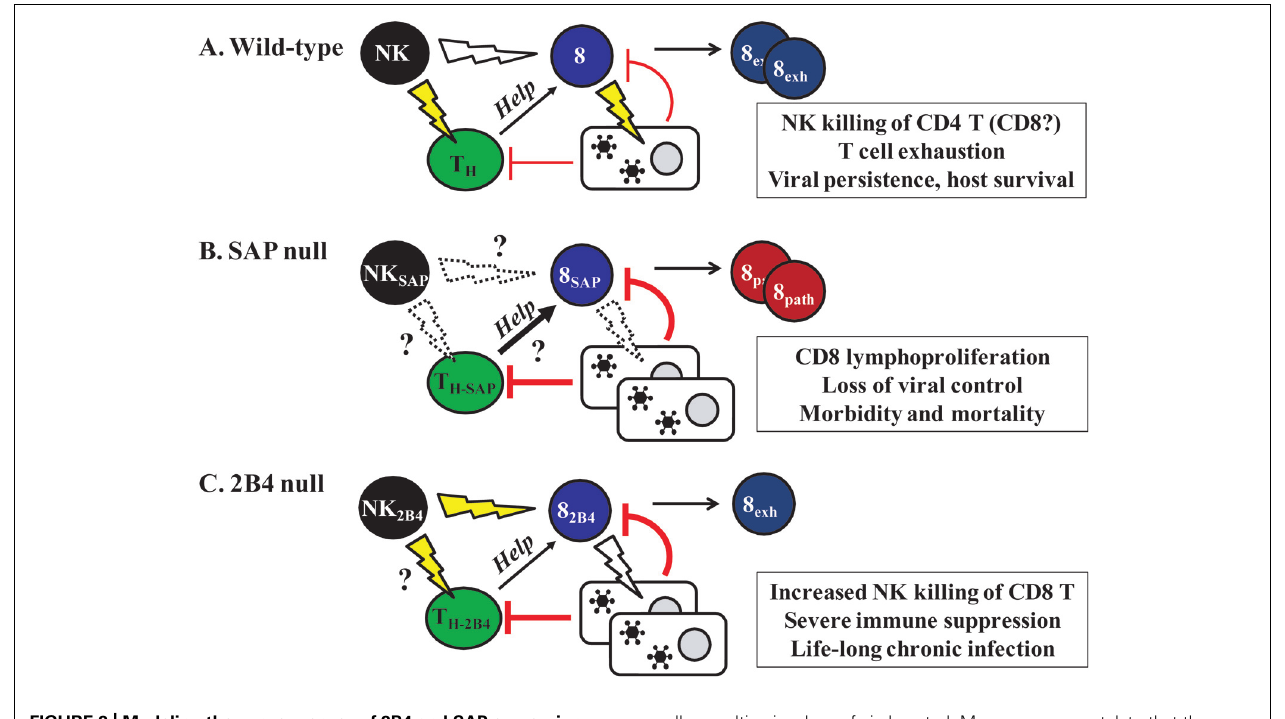
FIGURE 2 | Modeling the consequences of 2B4 and SAP expression in immunity to persistent virus infection in mice. (A) In a wild-type scenario, virus infection may trigger NK cell lysis of activated CD4T helper cells and to a lesser extent activated CD8T cells.This results in less help from CD4T cells, thereby favoring a loss of CD8T cell anti-viral function in the context of high levels of replicating virus. Exhaustion of CD8T cells permits viral persistence with limited immunopathology. (B) In the absence of SAP, NK and CD8T cells exhibit an impaired ability to lyse virus-infected